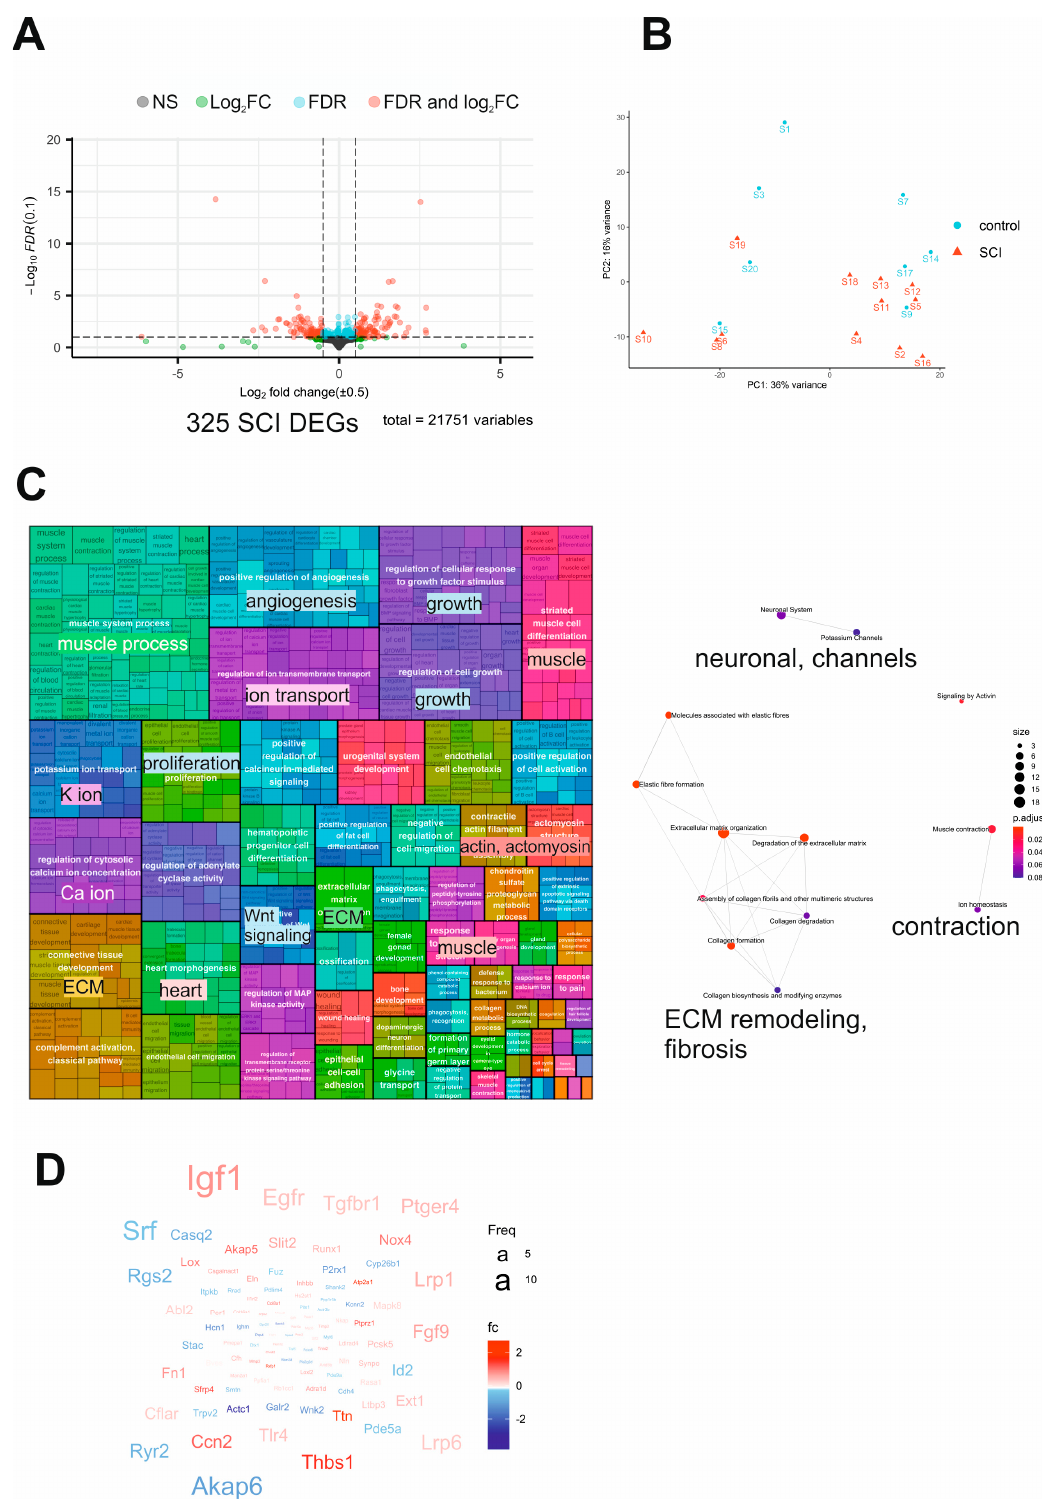
Figure 3. Transcriptome analysis of SCI mouse bladders. ( A ) Volcano plot of all mRNAs. Upregulated mRNAs are visualized in red color and downregulated in green. mRNAs with p -value < 0.05, absolute log2 fold change > 0.5 were selected for further analysis. ( B ) PCA of the RNA sequencing data in a 2D graph of PC1 and PC2 based on normalized read counts of all mRNA (325) with adjusted p -value < 0.05, absolute log2 fold change > 0.5, and mean of read counts > 50 reads. The bi-plot shows samples as labeled dots. ( C ) A treemap view of GO-term clusters (Biological Processes (BP)) and Reactome pathway analysis. ( D ) Word cloud of upregulated (in red) and downregulated (in blue) mRNAs, font size corresponding to the frequency of appearance in